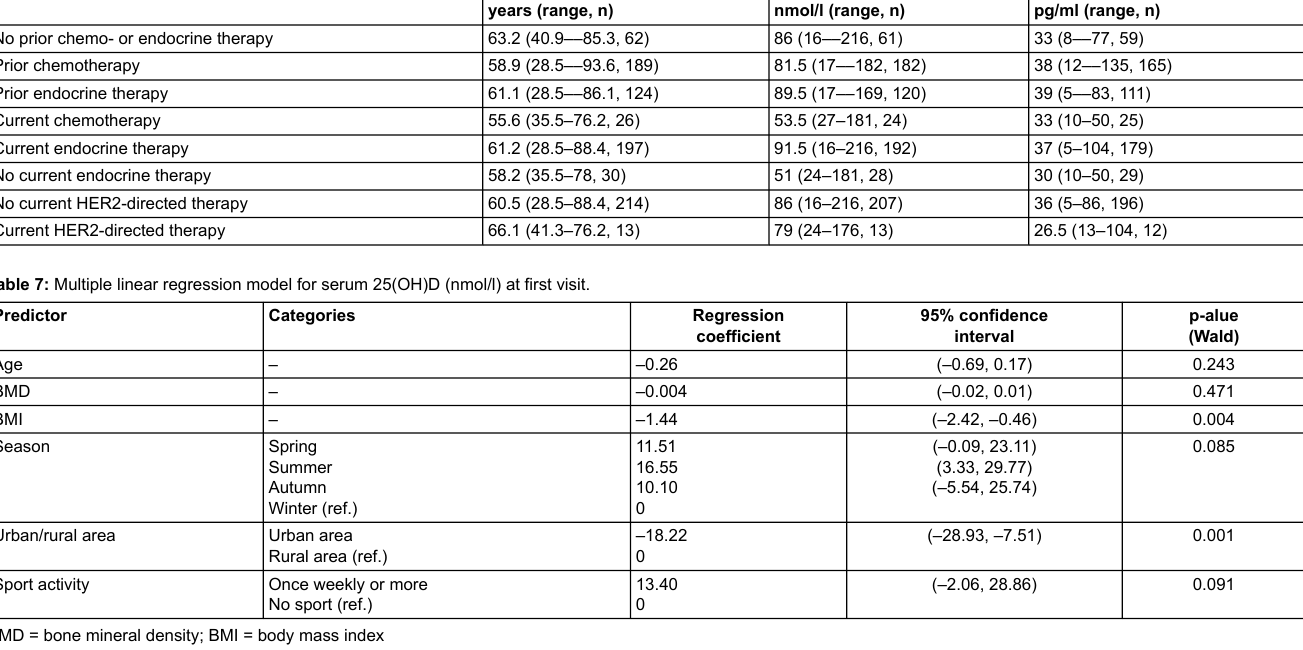
Table 6: Therapy modalities and serum 25(OH)D, 1,25(OH)2D levels. Types of therapy undergone by patients